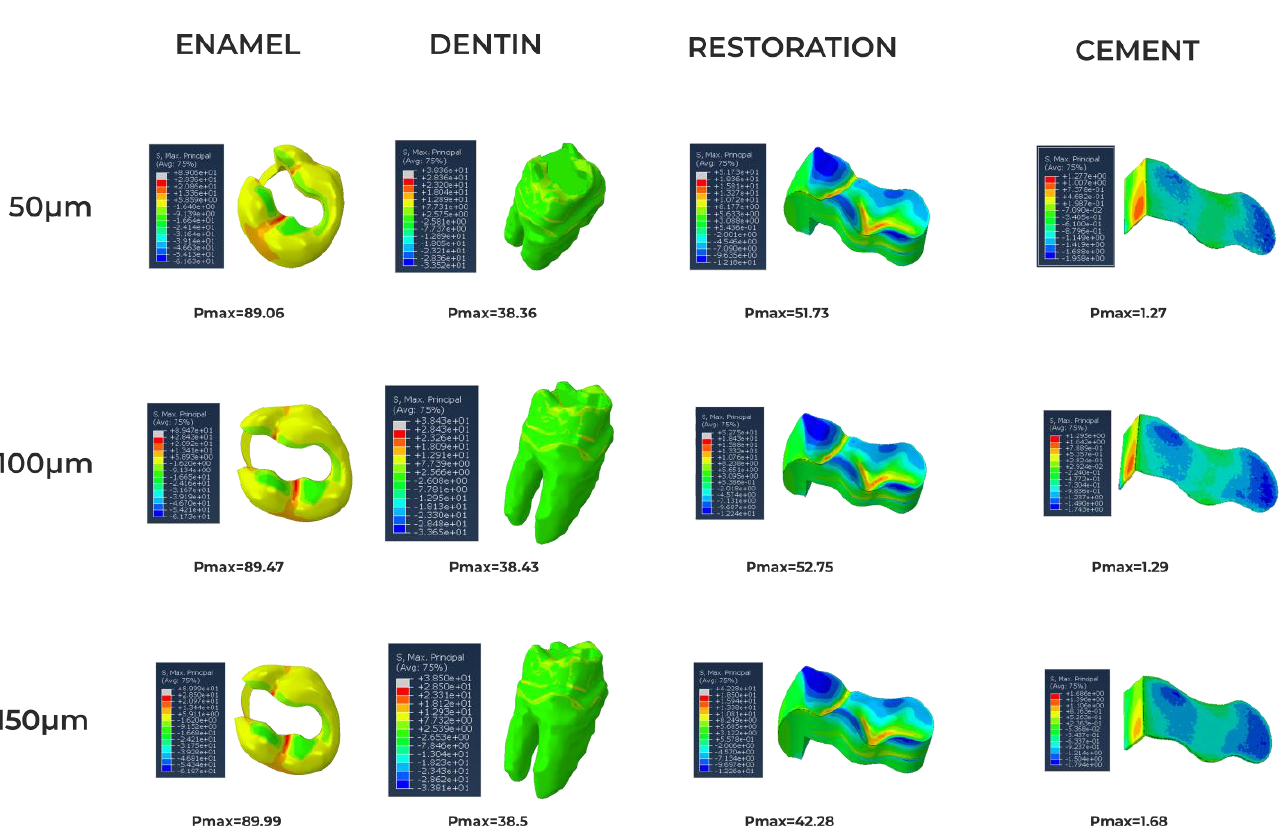
Figure 5. Maximum principal stress distribution in the enamel, dentin and restoration with different thicknesses of GI cement used with the amalgam (35 GPa Young’s modulus of amalgam). It was observed that in dentin tissue after glass ionomer cement was applied, 38.5 MPa stress accumulation was found in the presence of 150 μ m thick cement, 38.43 MPa in the presence of 100 μ m thick cement and 38.36 MPa in the presence of 50 μ m thick cement (Figure 6).